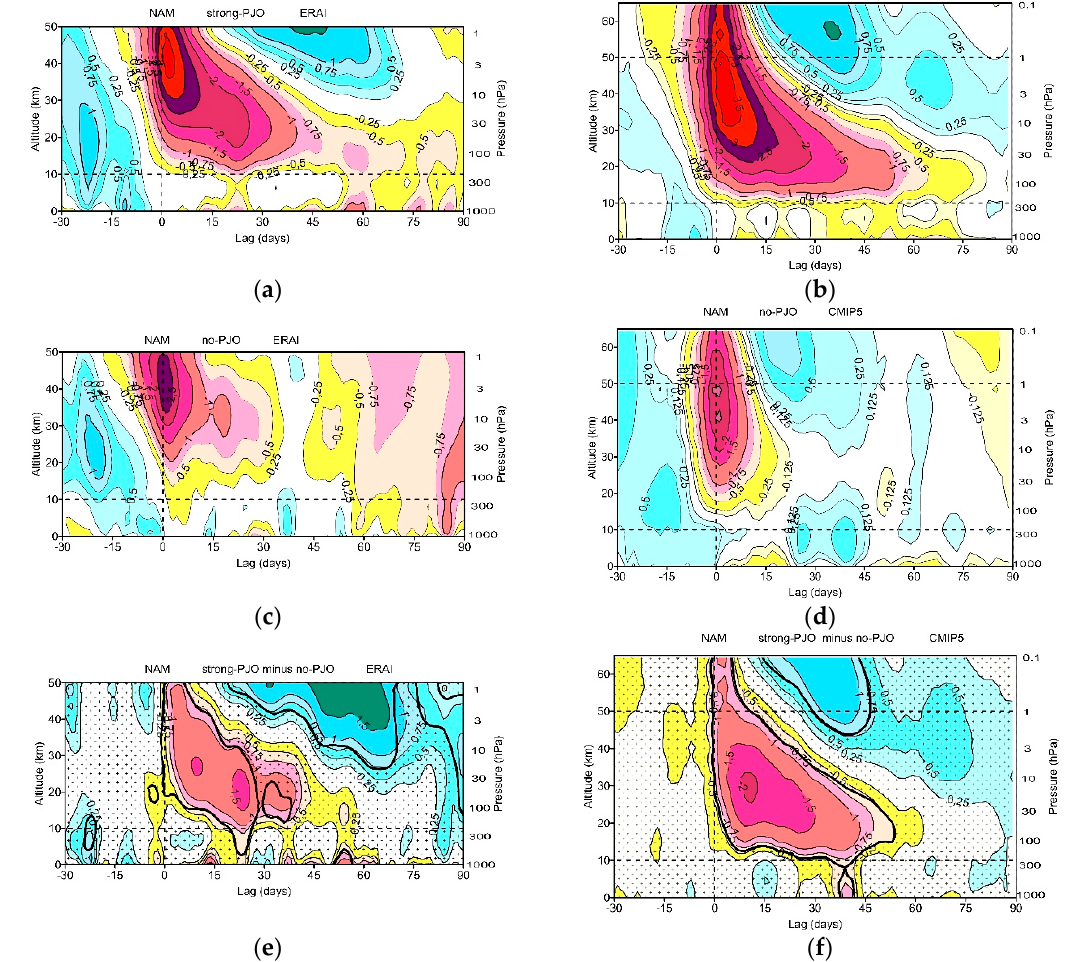
Figure 1. Evolution of northern annular mode (NAM) for ERA-Interim ( left column ) and CMIP5-ESM-LR ( right column ) for strong-PJO ( a , b ) and non-PJO ( c , d ). Panels ( e , f ) show the difference between strong-PJO and non-PJO composites, respectively; hatched areas are where the difference is statistically insignificant. Areas enclosed by thick black lines are statistically significant (95% confidence level). Vertical dashed lines mark CD, and horizontal dashed lines approximately show the tropopause and the stratopause. NAM, at each pressure level, is defined as the polar cap integrated geopotential height anomaly normalized by its mean standard deviation. ERA is the abbreviation for ECMWF re-analysis. CMIP5 stands for Coupled Model Intercomparison Project phase 5. ESM means Max-Planck-Institute Earth System Model, and LR stands for Low Resolution. PJO is the polar-night jet